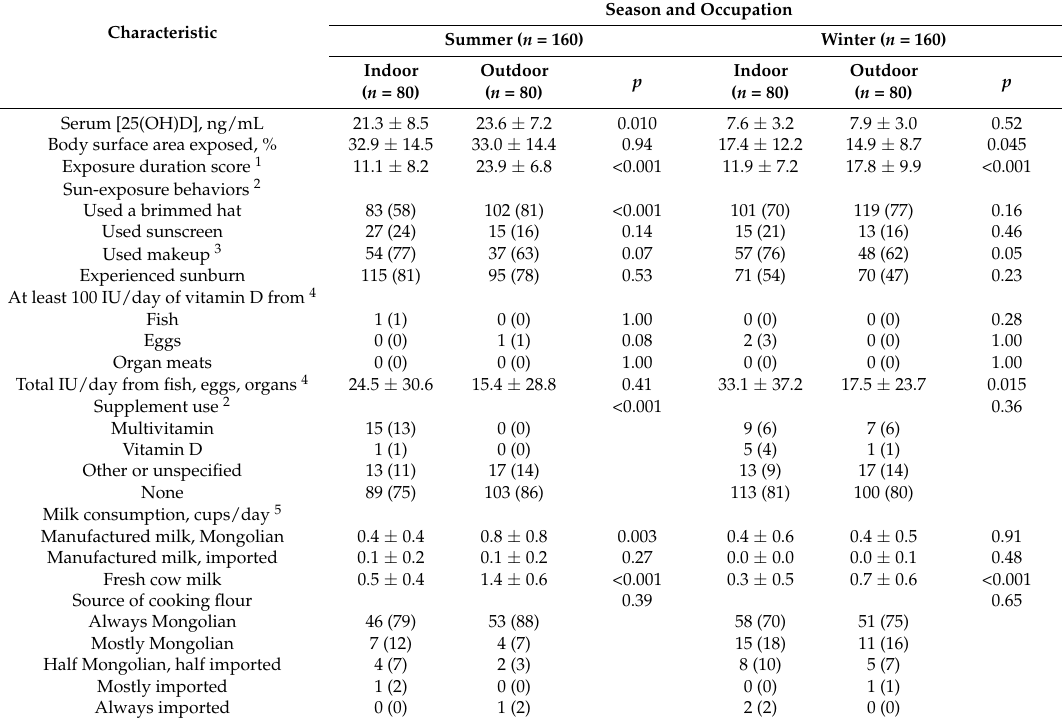
Table 2. Seasonal characteristics of study